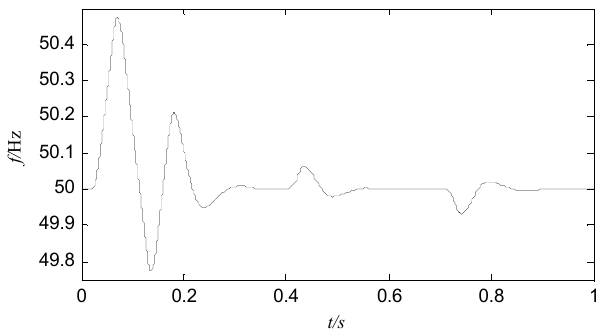
Figure 20. The frequency response of the micro ‐ grid.